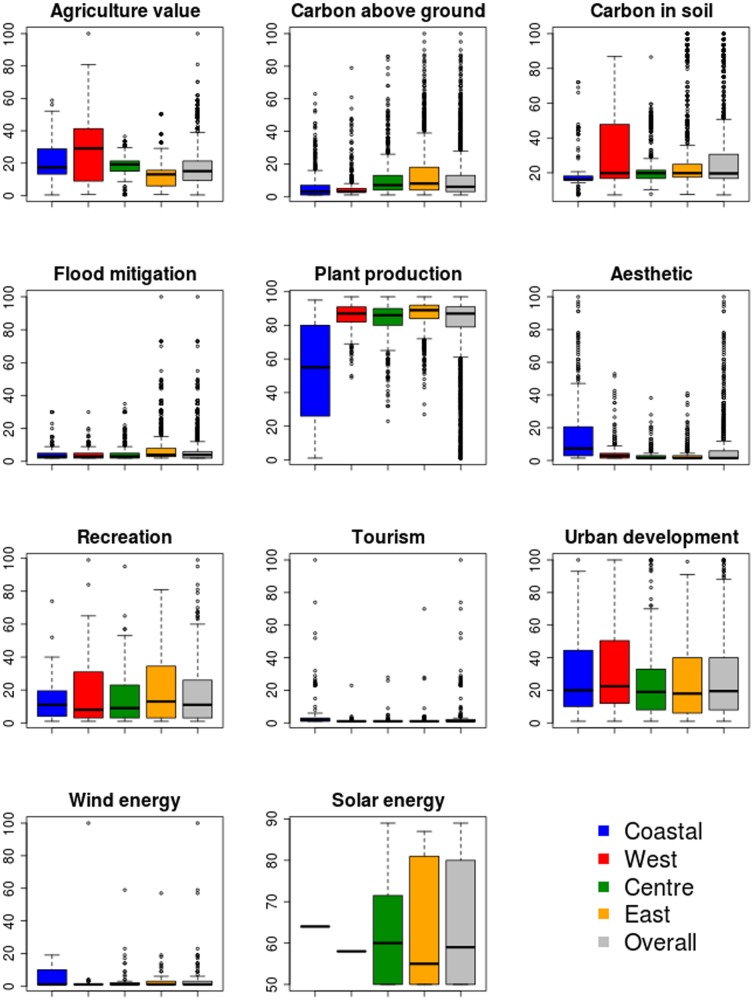
Zonal statistics of environmental services in Cornwall and within zones thereof.Shown are the median value (central line), upper quartile (edges of boxes), maximum and minimum values excluding outliers (whiskers) and outliers (dots).